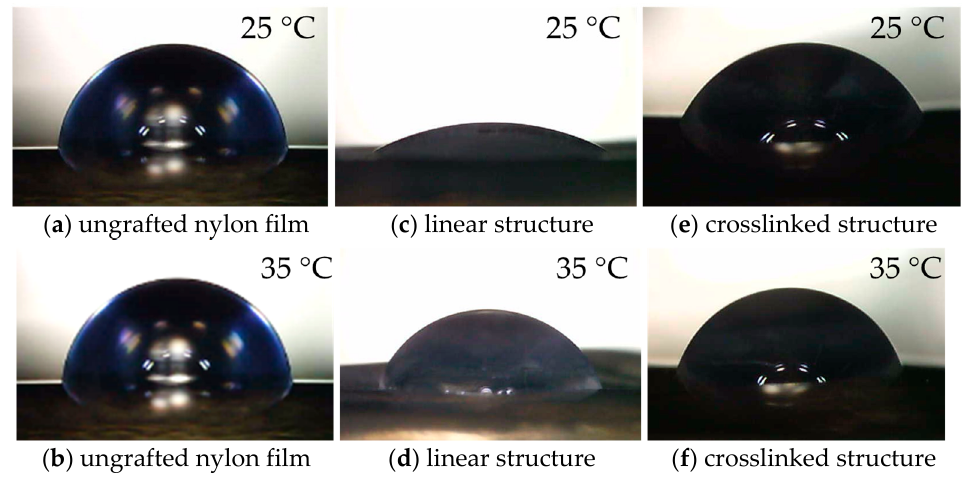
Figure 4. Water contact angles images at 25 and 35 °C of ( a ), ( b ) ungrafted nylon film, ( c ), ( d ) linear structure, PNIPAm-grafted nylon film ( Y = 16%) and ( e ), ( f ) crosslinked PNIPAm-grafted nylon film ( Y = 10%).